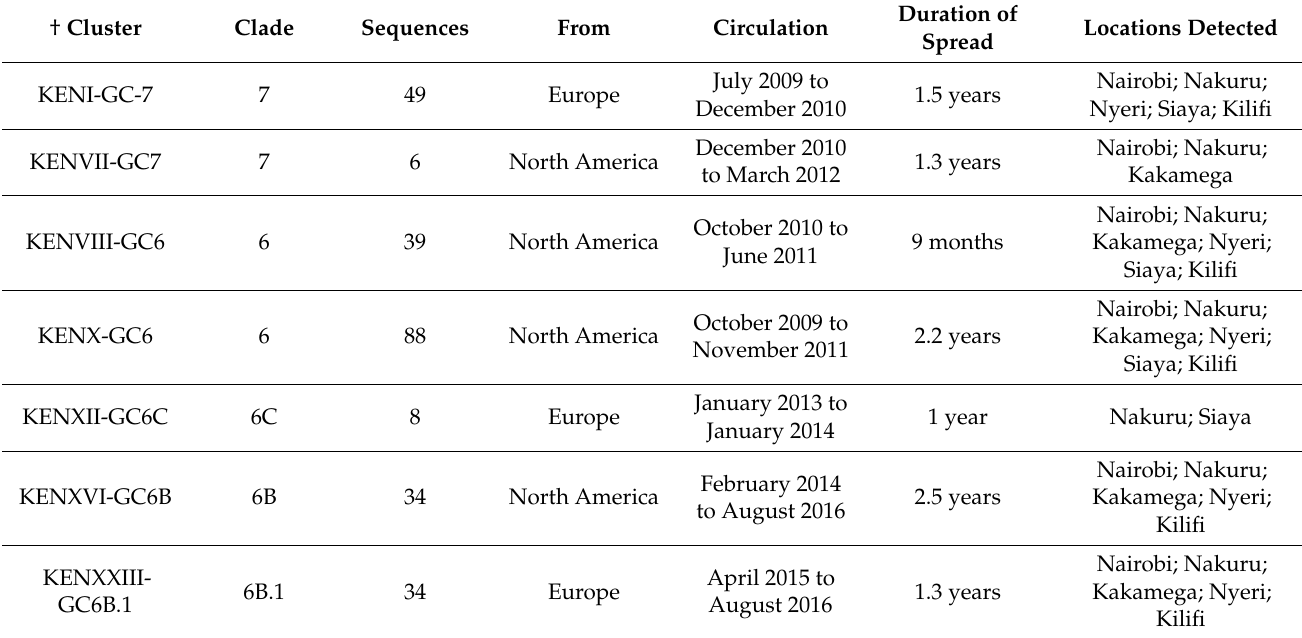
Table 1. Patterns of persistence of A(H1N1)pdm09 virus transmission clusters in